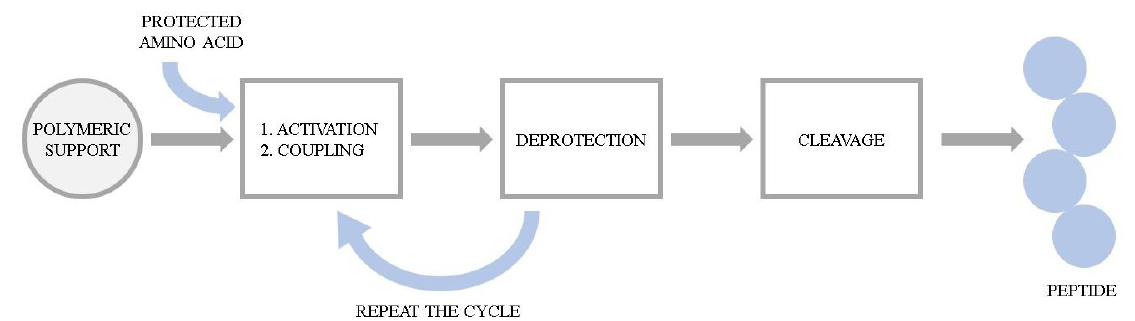
Figure 4. The general scheme of Fmoc solid phase peptide